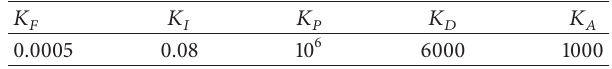
Table 6: Reference values of the PI System.